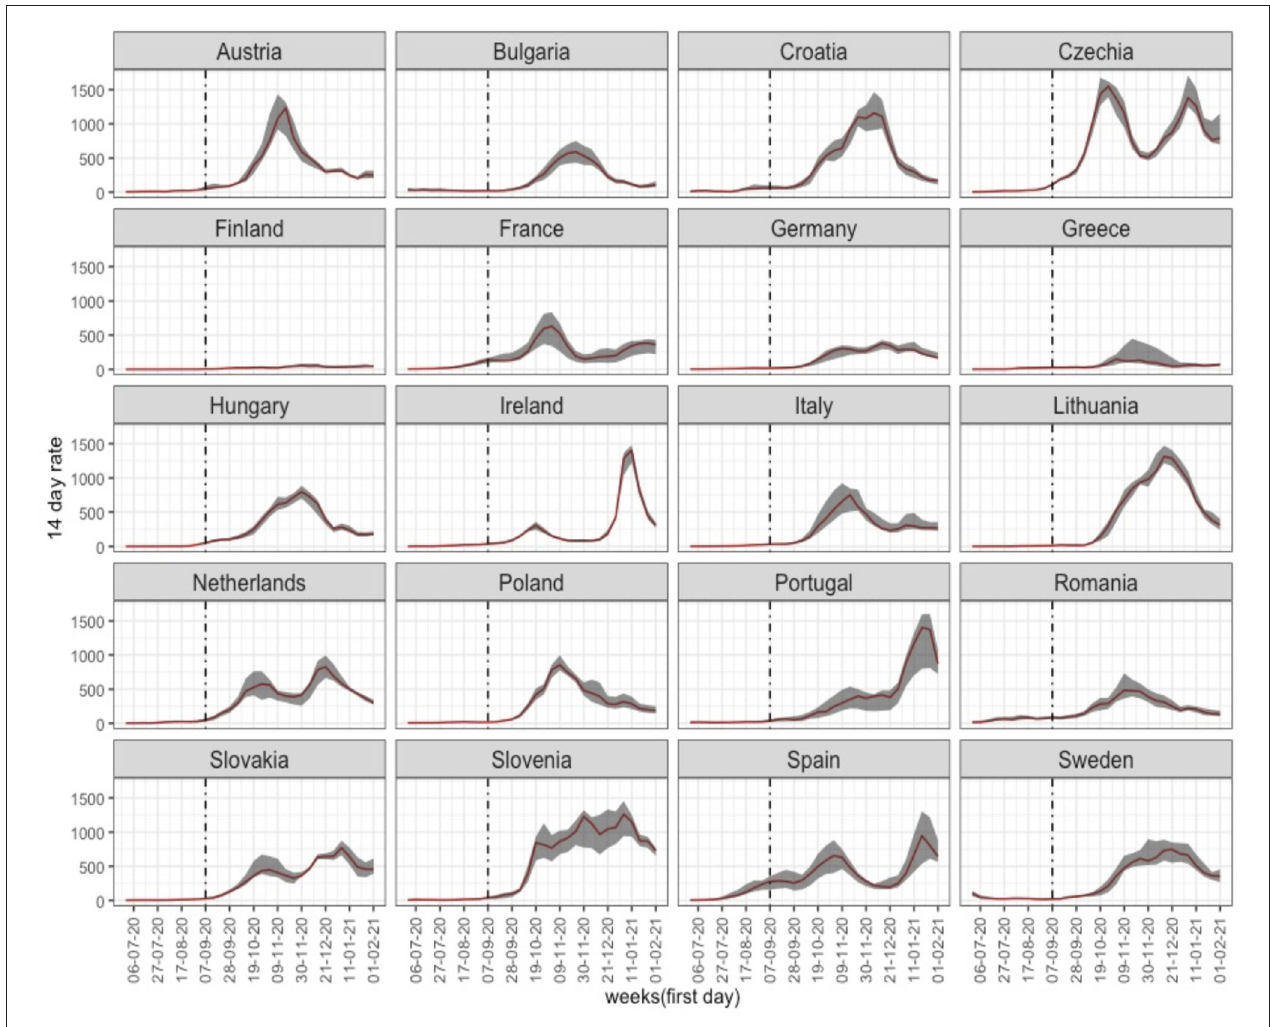
FIGURE 1 | Fourteen-day COVID-19 incidence rates in 20 EU countries from week 27/2020 to week 4/2021. Median regional rates in each country (red line) and interquartile range (grey